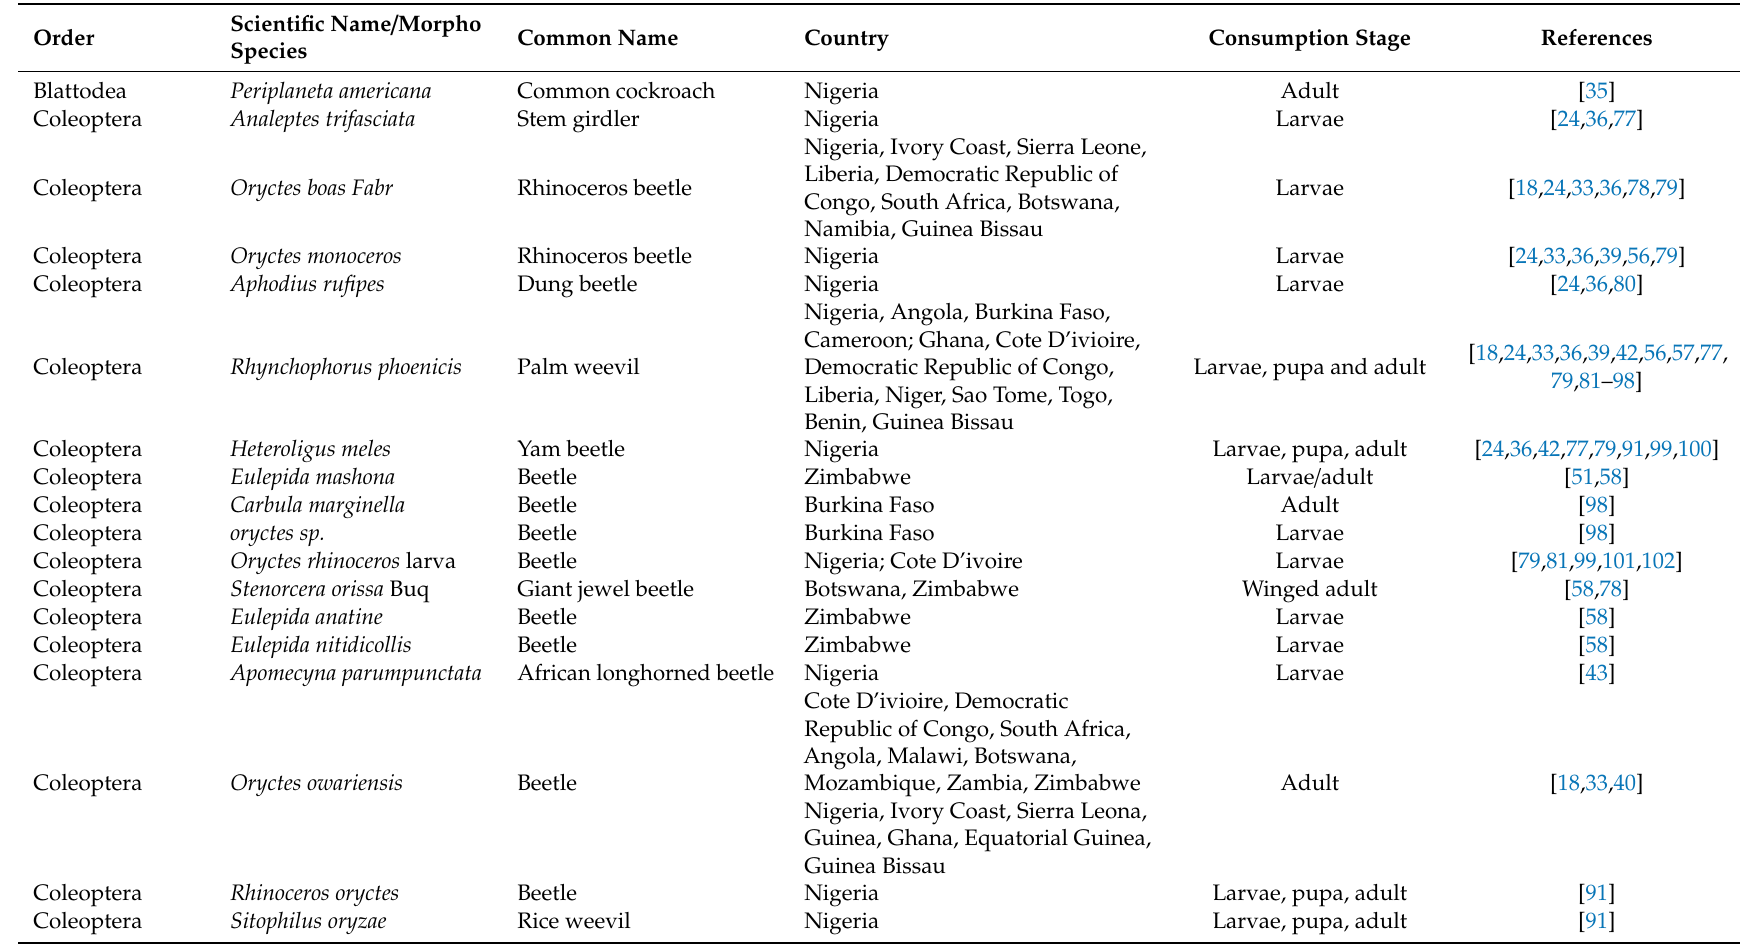
Table A1. Edible insects consumed in di ff erent African